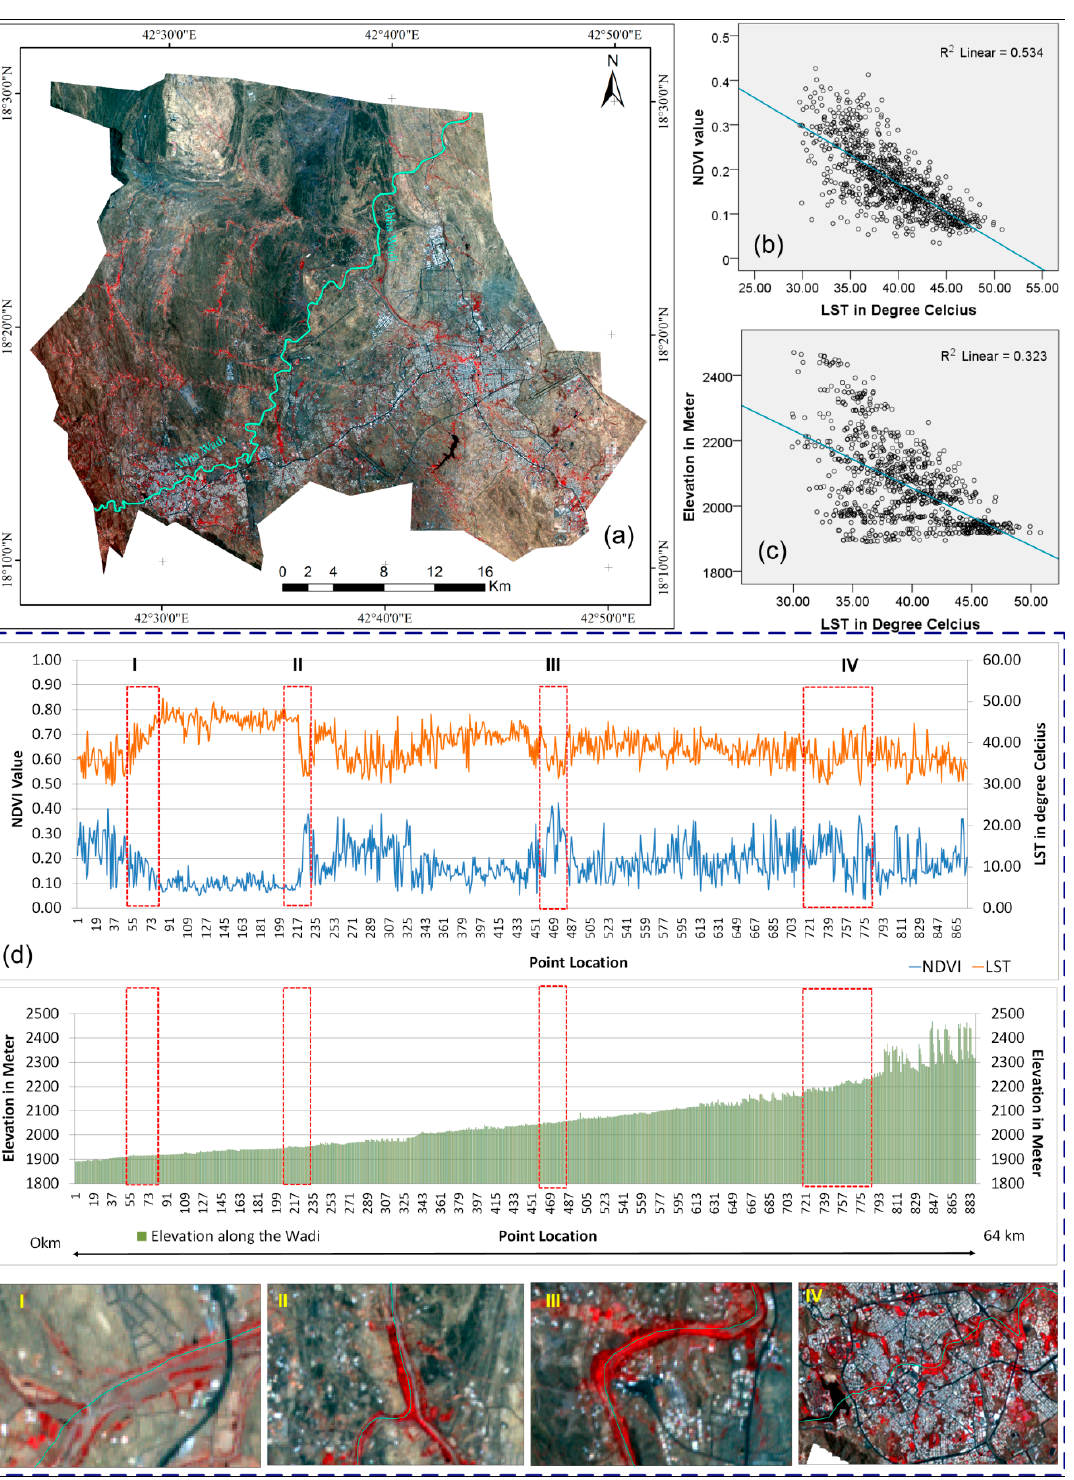
Figure 7. A profile map drawn along the Abha wadi ( a ); linear regression between LST–NDVI along the Abha wadi ( b ); linear regression between LST–elevation along the Abha wadi ( c ) and graphic representation of the data distribution of NDVI and LST along the Abha wadi; elevation variability and closer field of view of the False Color Composite Image of ASTER to their respective boxes (i.e., red) ( d ).